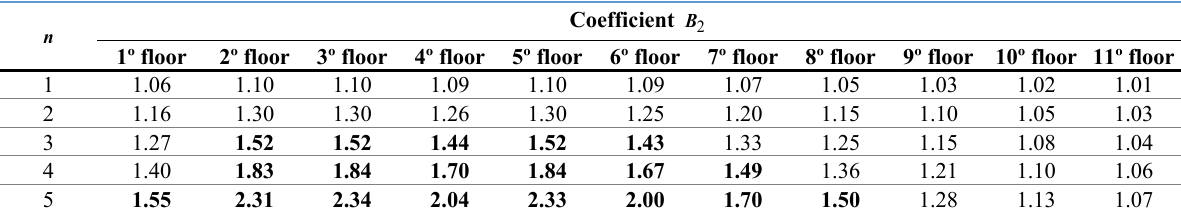
Coefficient 2 B